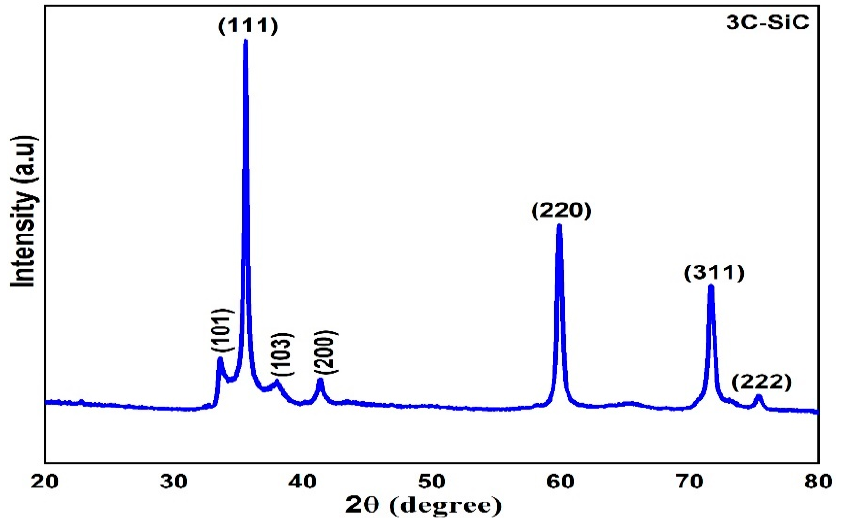
Figure 3. A representative powder XRD of 3C-SiC under ambient circumstances.